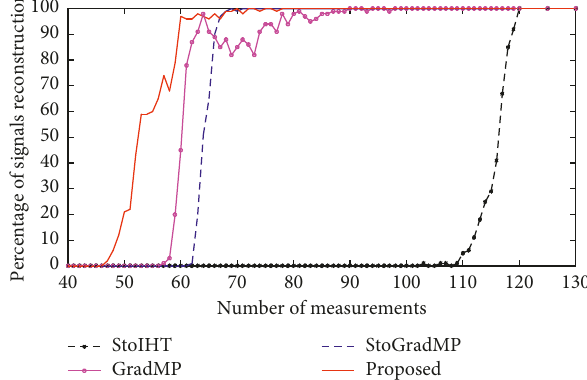
Figure 6: Reconstruction probability of different algorithms with different measurements ( n